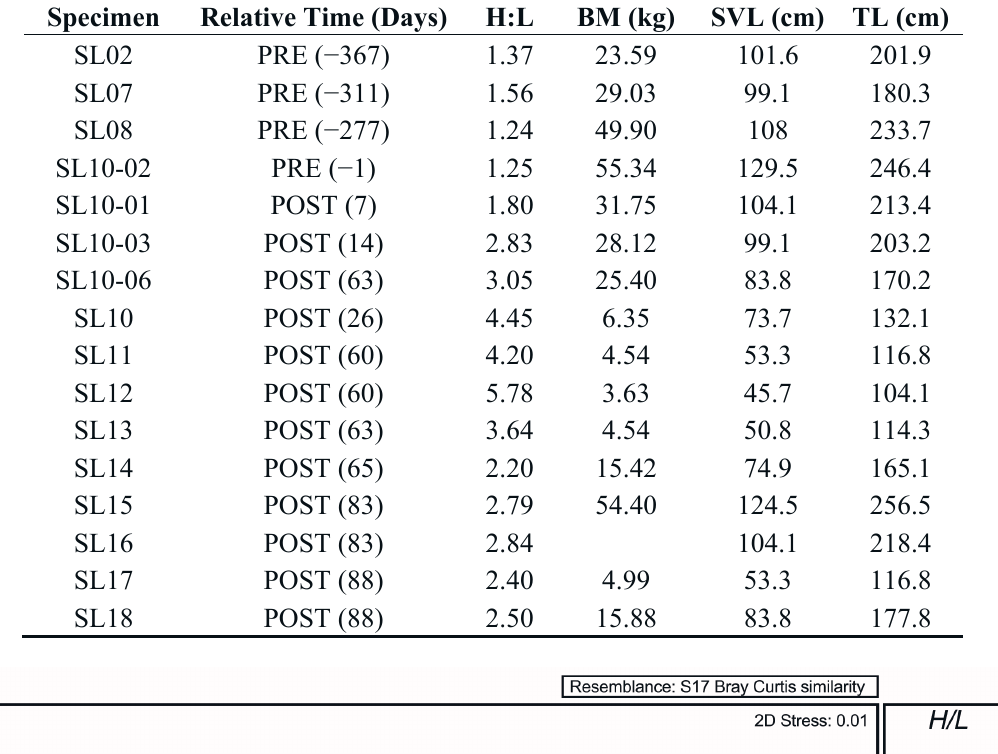
Table 1. Morphometrics and H:L Ratio data from alligators relative to onset of disturbance.